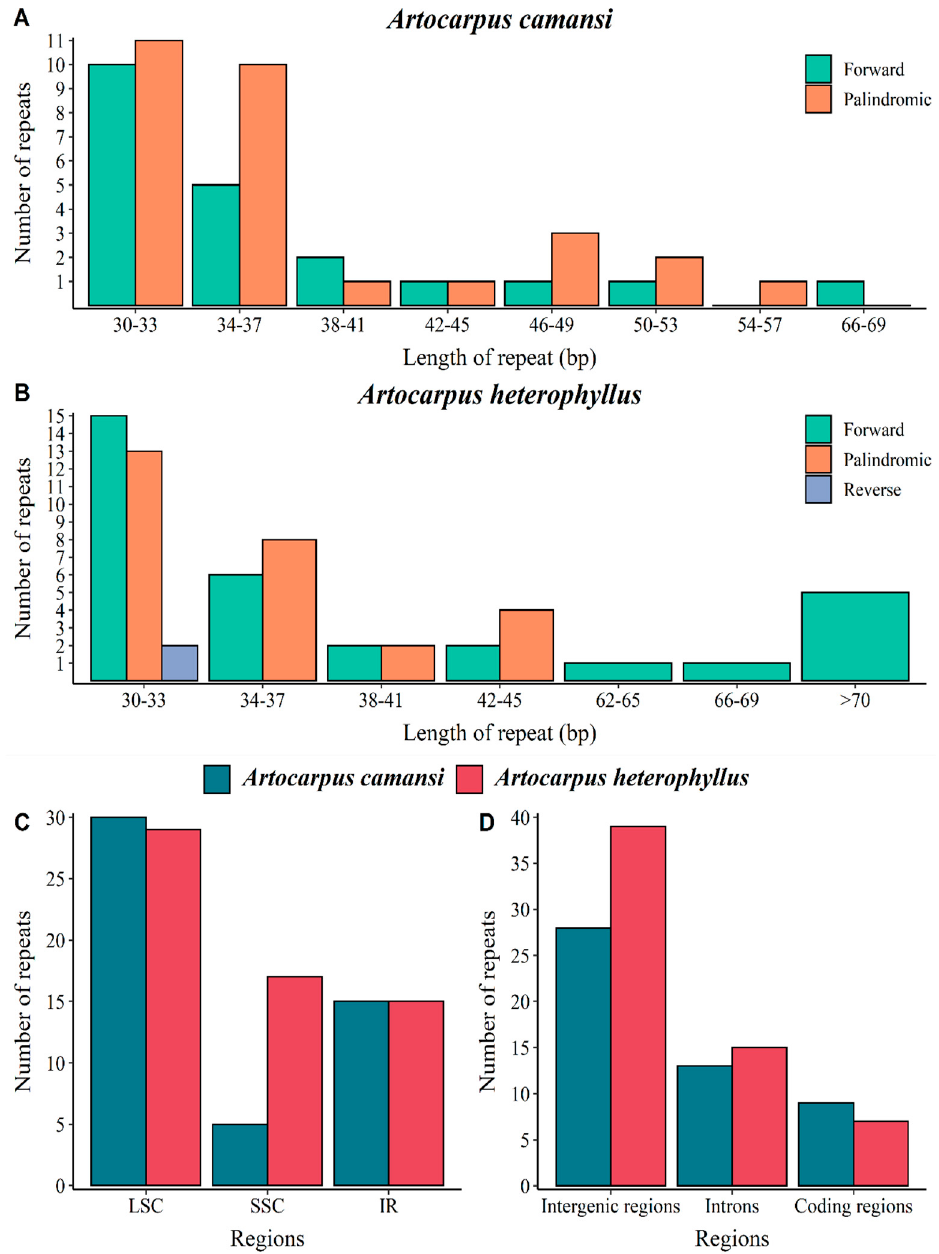
Figure 3. Distribution of the repeat structures in the Artocarpus plastid genome. ( A ) The number of repeat structures in the A. camansi plastid genome; ( B ) The number of repeat structures in the A. heterophyllus plastid genome; ( C ) The number of repeat structures in the different regions of the plastid genomes of the two species; ( D ) The number of structures in intergenic and coding regions, and the introns.